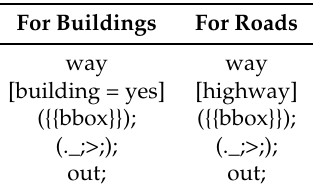
Table 1. Overpass application programming interface (API) query used to extract information about roads and buildings from the OpenStreetMap (OSM) database.